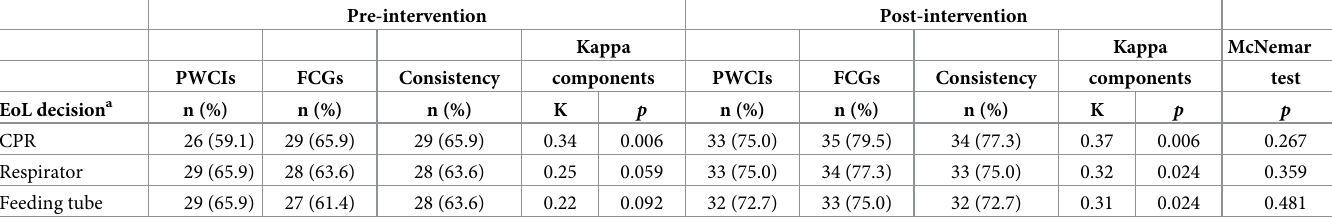
Table 6. Consistency between PWCIs and FCGs for life-sustaining End-of-Life (EoL) decisions pre- and post-intervention (n = 44 dyads).